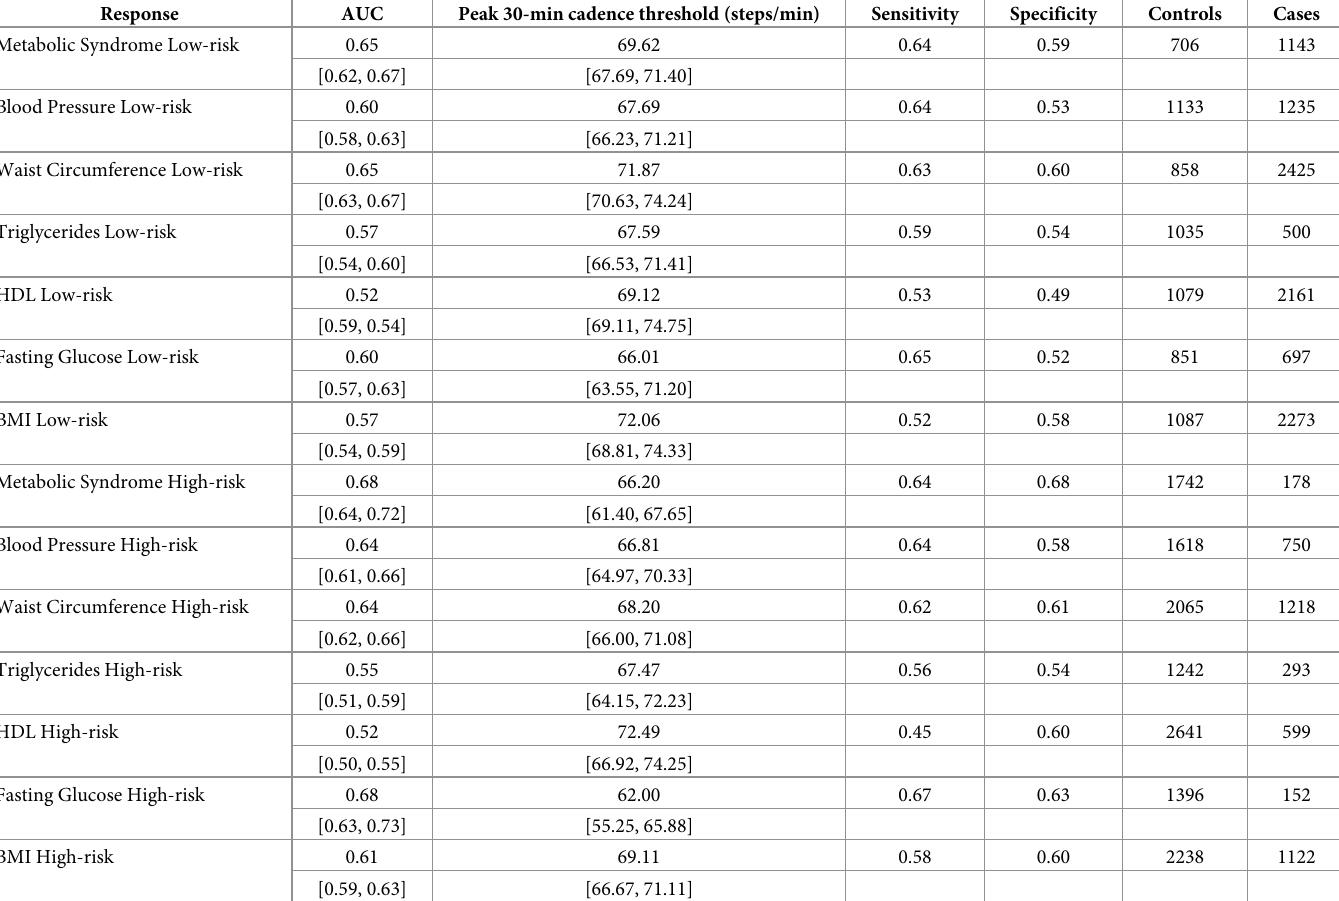
Table 3. Peak 30-min cadence, AUC and thresholds to classify each of the known cardiometabolic risk factors. Peak 30-min cadence above the threshold classifies positive health outcomes. Response